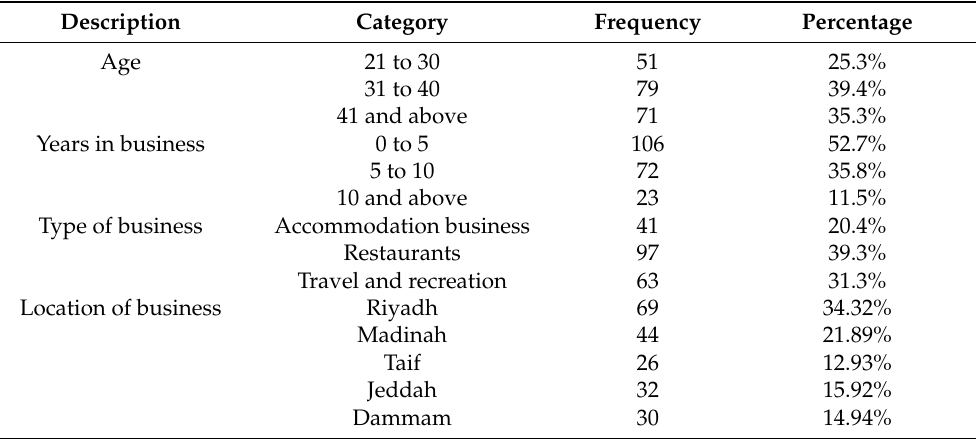
Table 1. Demographic characteristics of the